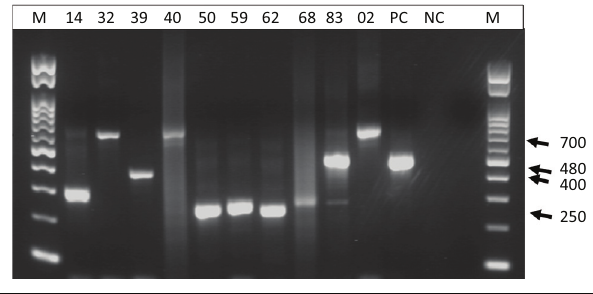
FIGURE 2: Representative positive products amplified by internal transcribed spacer 1-PCR, polymerase chain reaction were electrophoresed. Sample